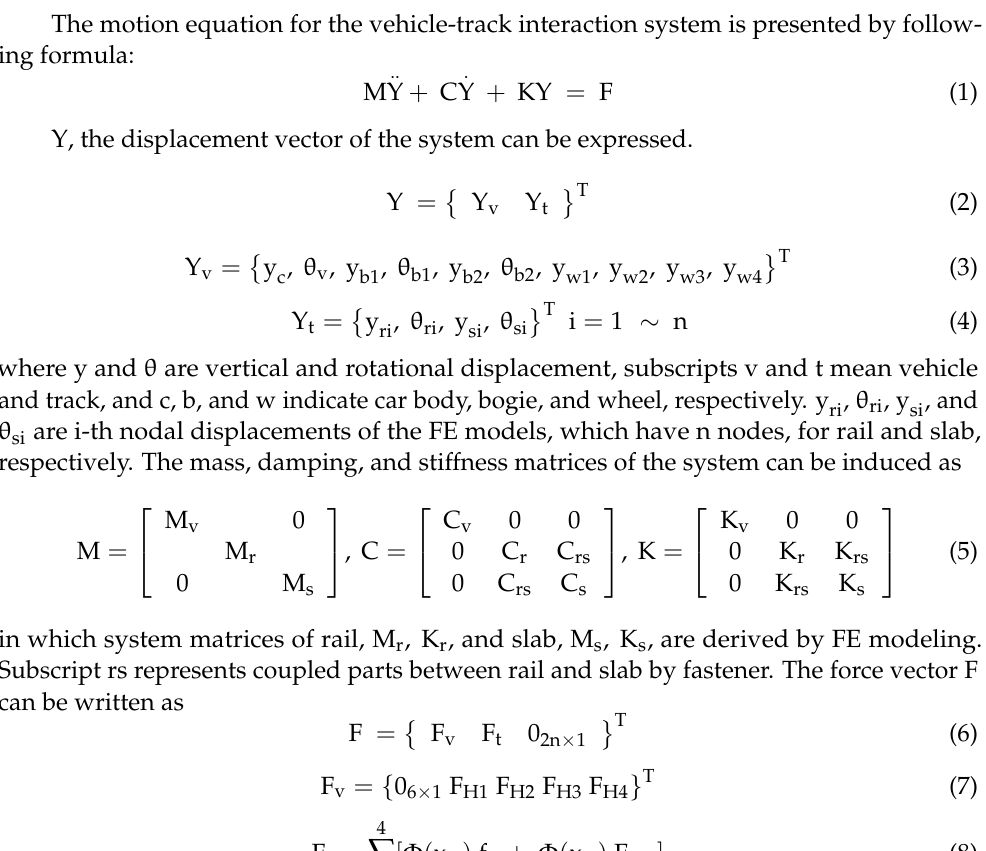
Figure 5. Train-track interaction analysis model.